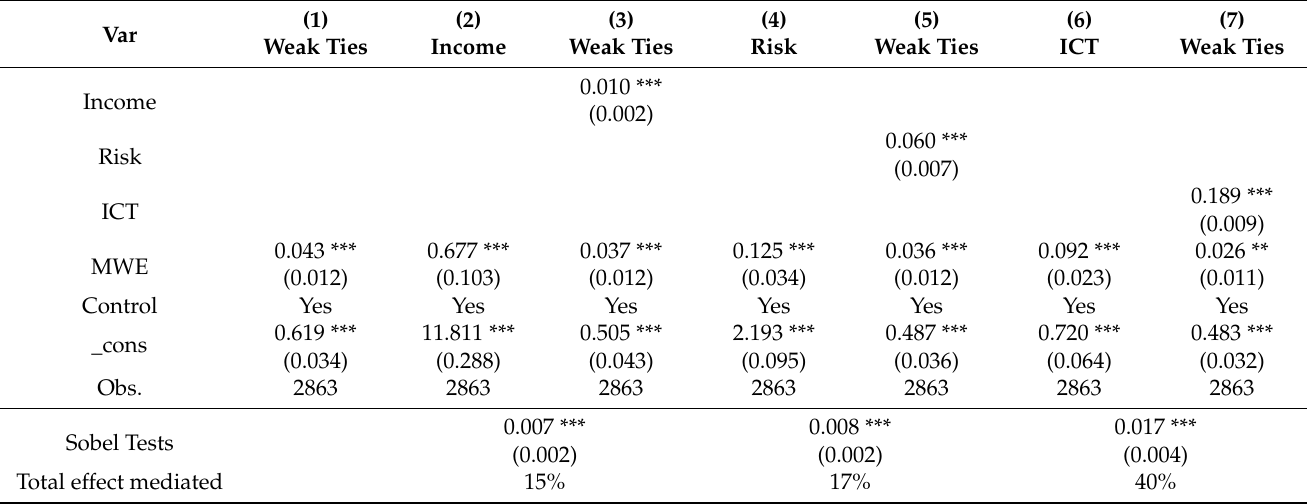
Table 6. Direct Effects and Mediating Effects on Weak ties in Social Capital.